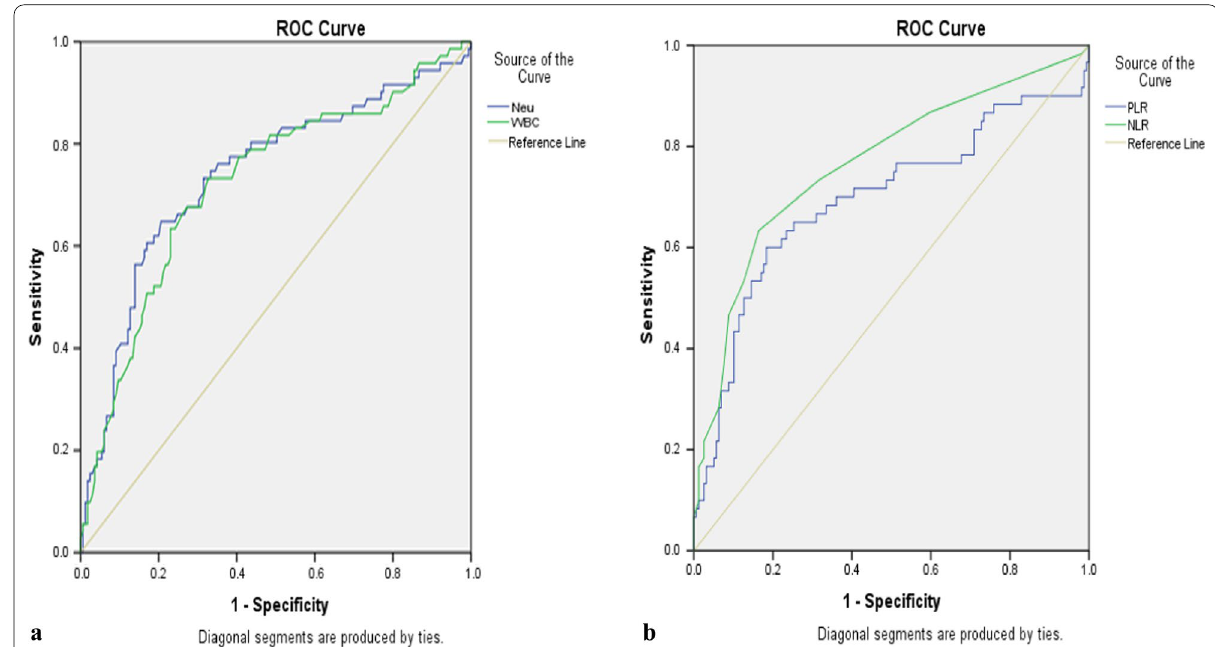
Fig. 1 a, b Receiver operating characteristic (ROC) curve showing the relative diagnostic performances of neutrophils (Neu), white Blood cells (WBC), neutrophil–lymphocyte ratio (NLR), and platelet–lymphocyte ratio (PLR). The cutoff points detected for hematologic parameters with good